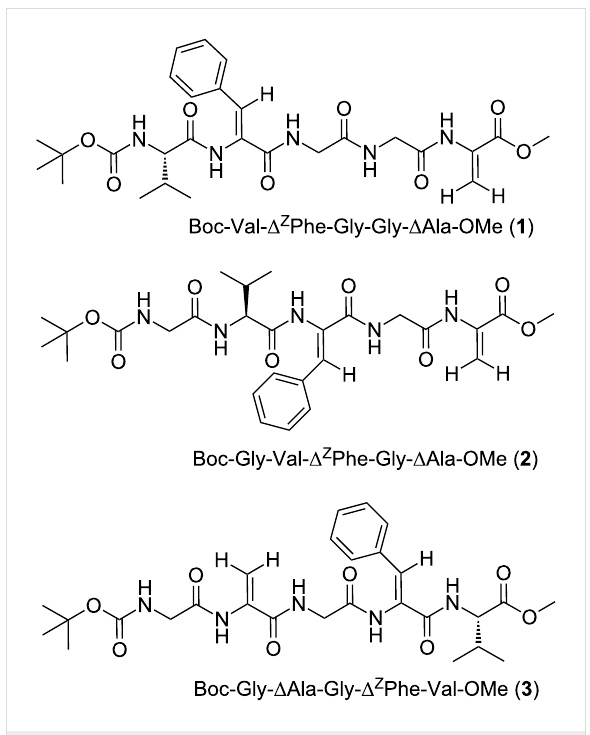
Figure 1: Sequences of the investigated